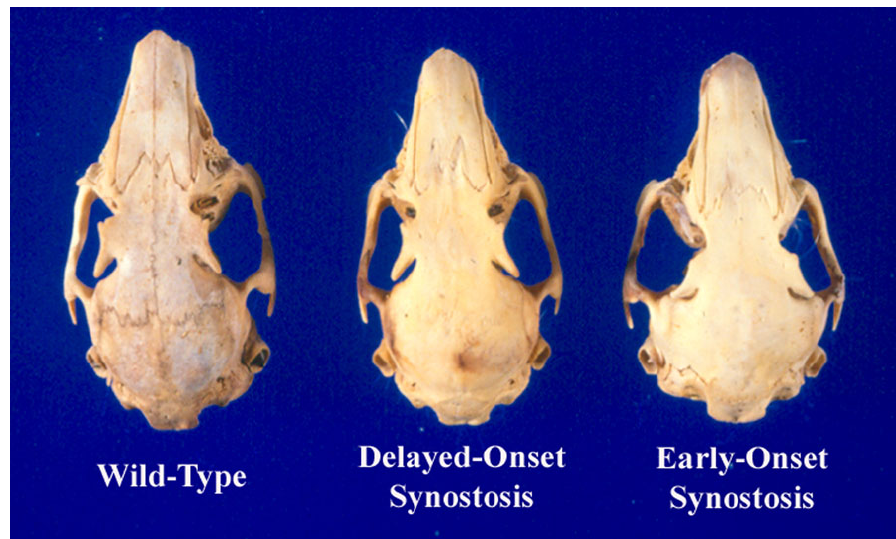
Figure 1. Superior view of skulls from a 42 day wild-­‐type normal control rabbits and rabbits with late-­‐onset (postnatal) and early-­‐onset (prenatal) coronal suture synostosis. Note the shorter, wider cranial vaults in the rabbits with coronal suture synostosis compared to the wild-­‐type rabbit